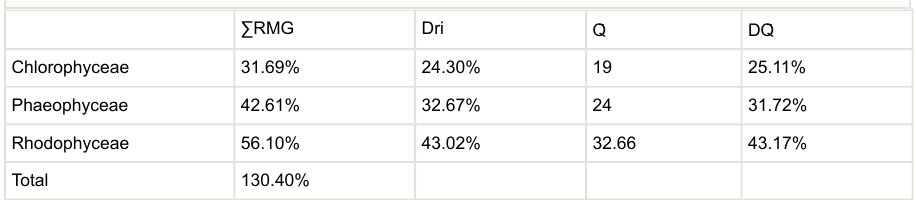
Table 4. Analytical parameters at the Small Port